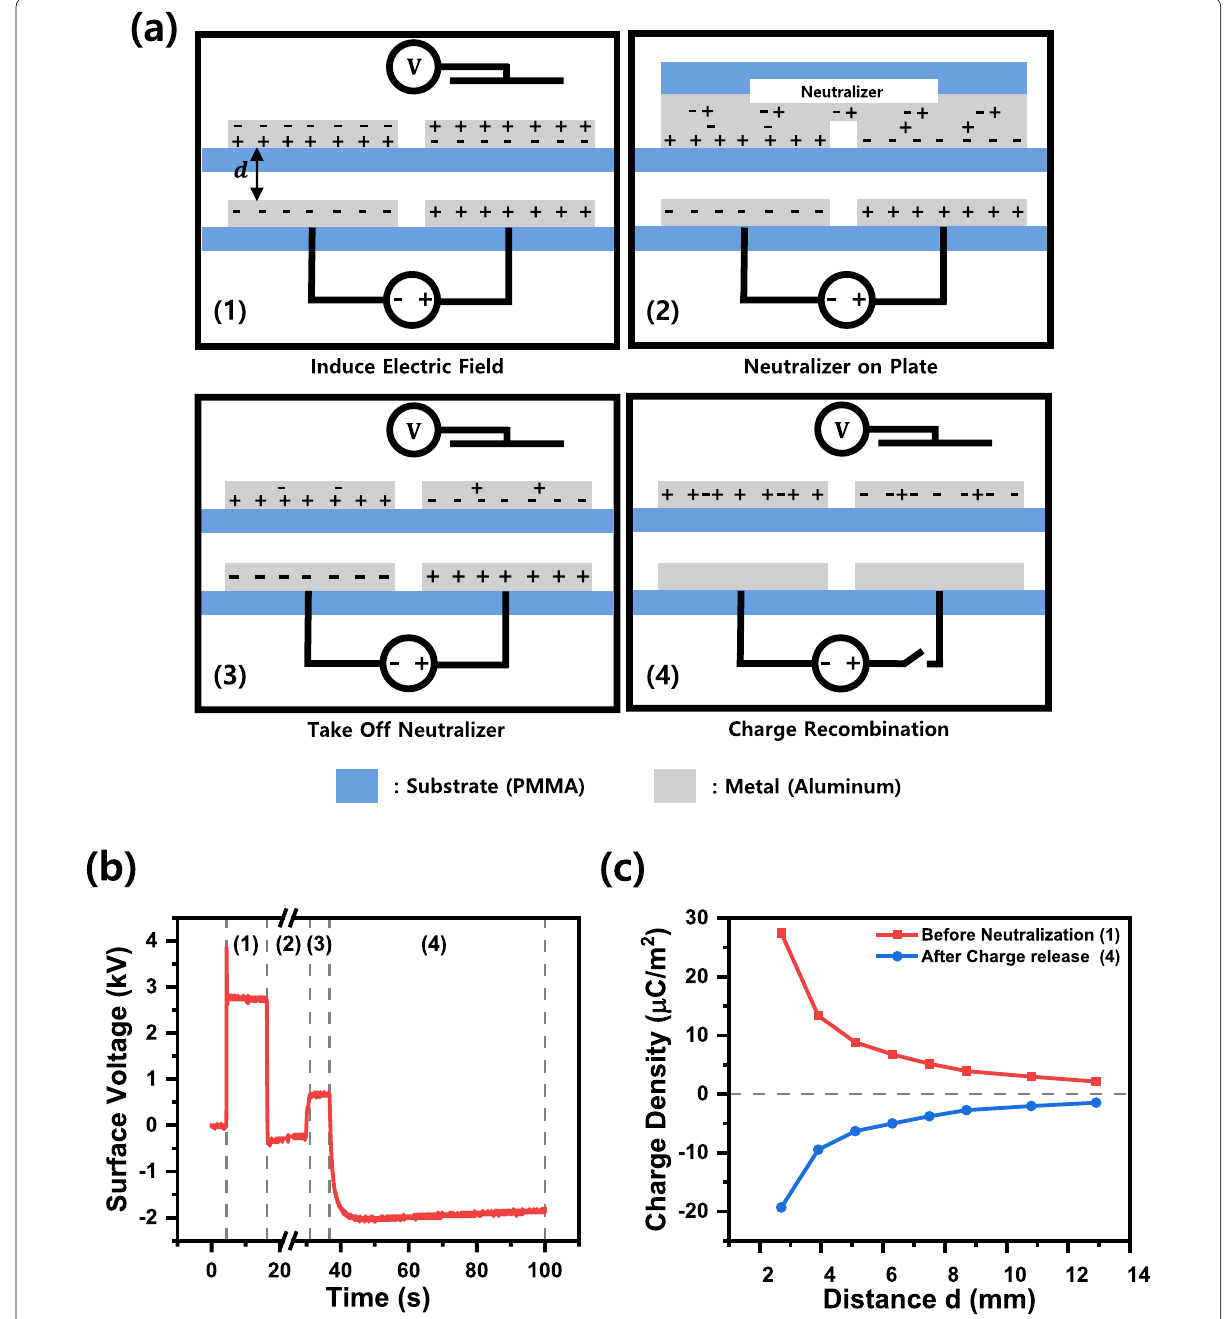
Fig. 3 Polarization model experiment of the metal electrode in the electric field. a The process of net charge in metal polarization and b metal’s surface voltage. c The charge density of the metal generated by the electric field [1] and the net charge is generated [4] according to the